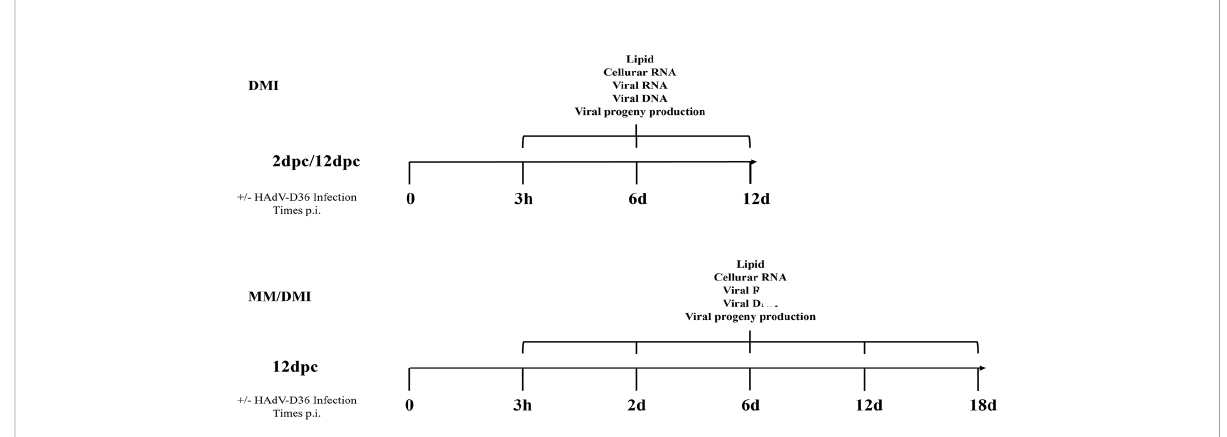
FIGURE 1 Experiment work fl ow. 3T3-L1 cells were infected with HAdV-D36 or mock-infected at 2 or 12 days postcon fl uence (2 dpc or 12 dpc, respectively), in the absence or presence of differentiation factors (MM or MDI, respectively). The cells were harvested at the indicated time- points when measurements of viral and cellular mRNA, viral DNA, viral progeny production and intracellular lipids were performed as described in materials and